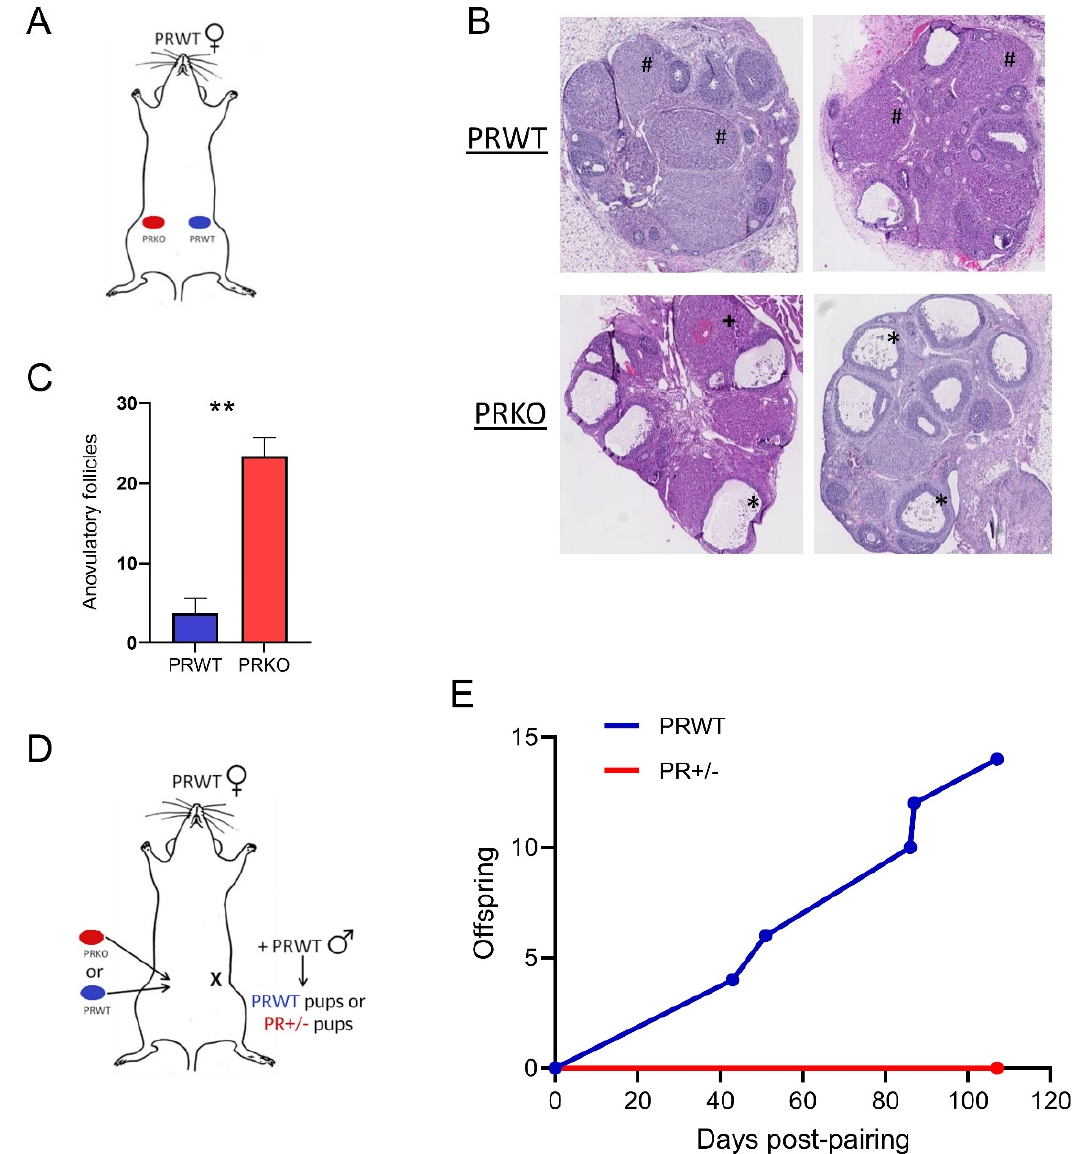
Figure 3. Ovarian progesterone receptor is essential for fertility. ( A ) Schematic of ovarian transplant design for histological assessment. Donor WT or PRKO ovaries were transplanted into the contralateral sides of recipient ovariectomized WT females. ( B ) Representative H&E images of transplanted WT and KO ovaries at 23 h post-hCG. Symbols represent follicle types: # normal luteinized follicles; * anovulatory unruptured follicles with expanded COCs; + anovulatory luteinized, unruptured follicles with entrapped oocytes. ( C ) Quantification of anovulatory follicles in KO vs. WT transplanted ovaries. Mean ± SEM; n = 3 donor ovaries per genotype. ** p < 0.01 by unpaired t -test. ( D ) Schematic of ovarian transplant design for fertility assessment. Ovariectomized recipient WT females were transplanted with either one WT ovary or one KO ovary then paired with WT stud males. ( E ) Offspring originating from a WT ovary (offspring PRWT) or KO ovary (offspring PR+/ − ) were tallied with numbers indicating total from litters of n = 3 transplanted recipients per genotype.